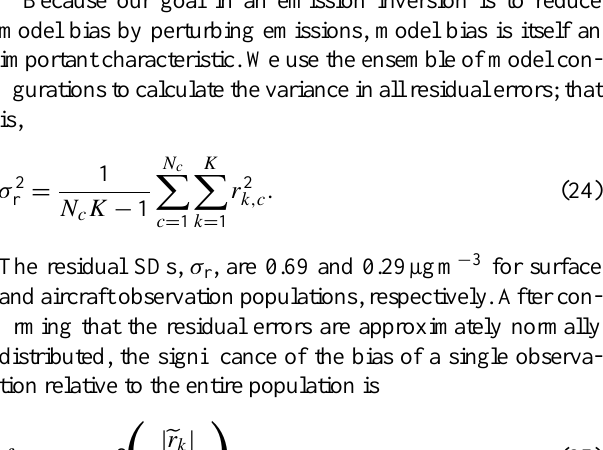
Figure 8. Model and total observation error SD ( σ k,m ,σ k ) vs. model residual error ( r k ) with adjoint-forcing ( λ ∗ to w k = 1 for (a) surface and (b) aircraft observations. 1 σ and 2 σ zones reflect regions of increasing statistical